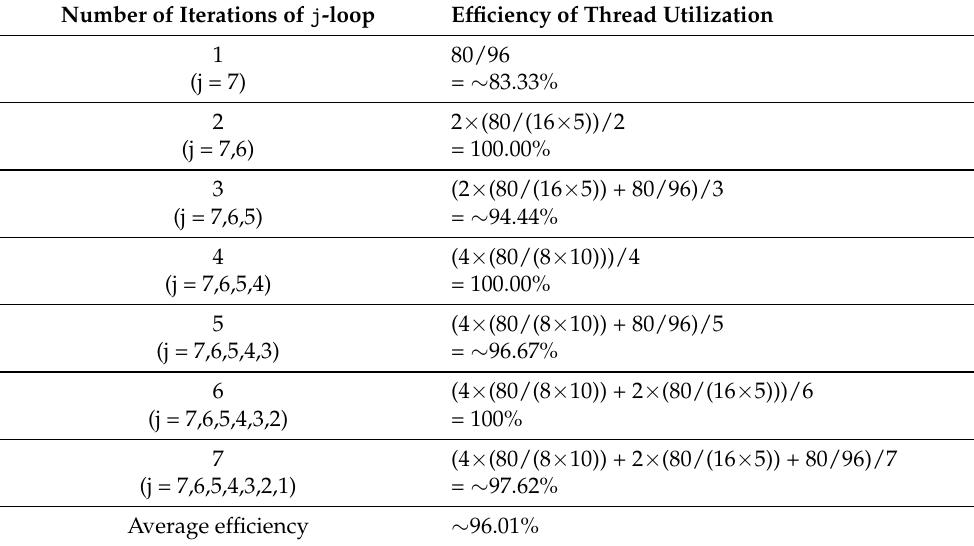
Table 1. Efficiency of thread utilization obtained with the policy of thread scheduling proposed in this